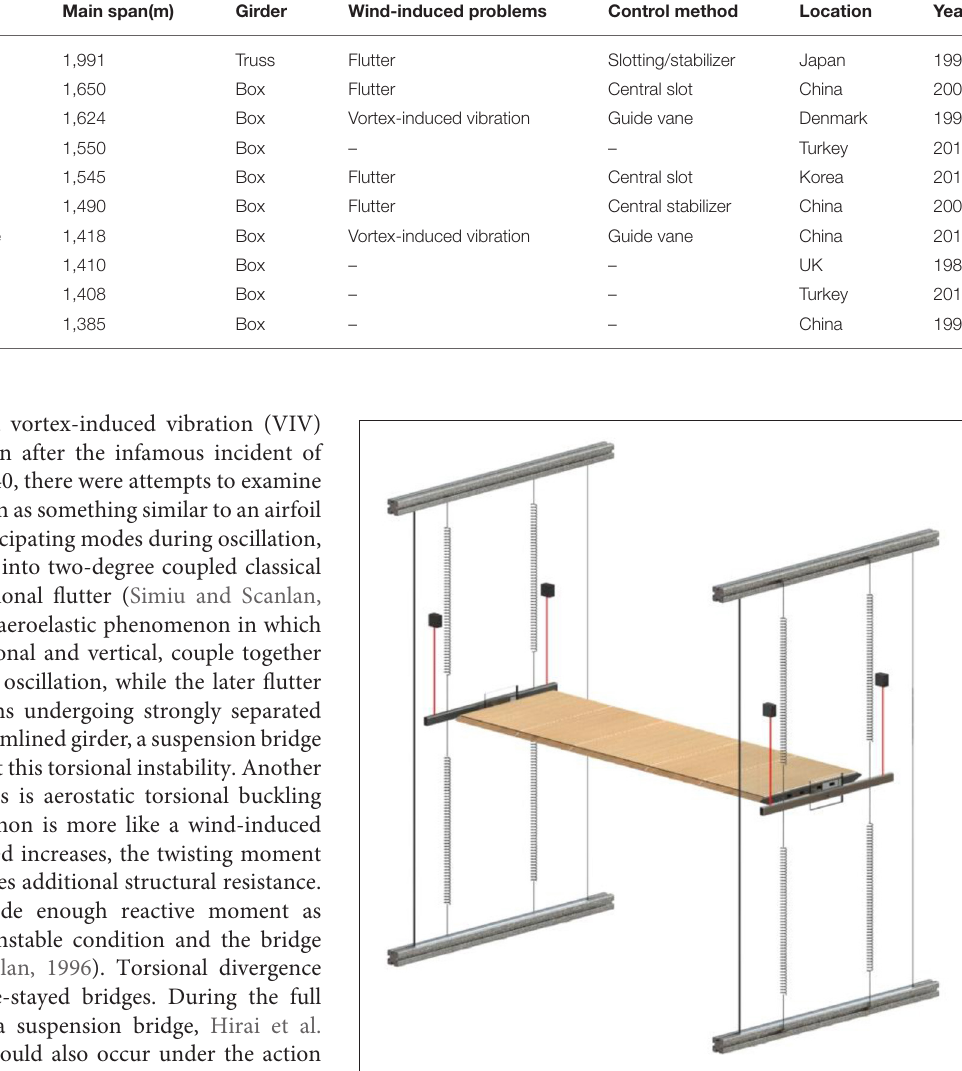
FIGURE 1 | Configuration of a sectional model.